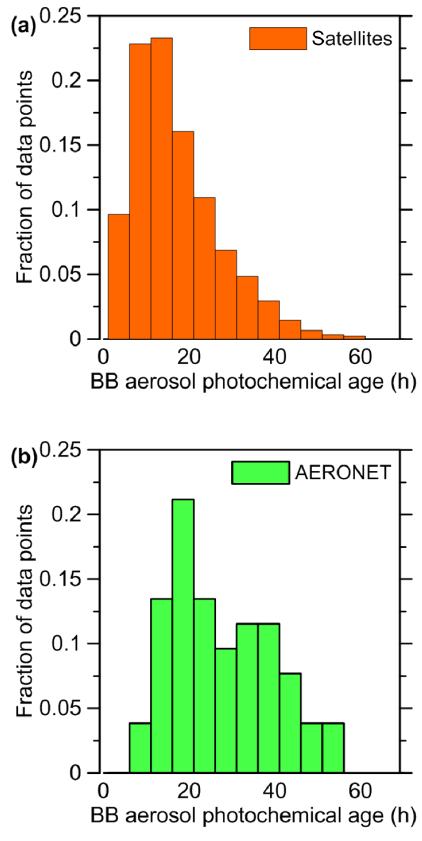
Figure 15. Histograms of the BB aerosol photochemical ages estimated in accordance with Eq. (1) for the (a) satellite and (b) AERONET data selected for this study. Note that very minor fractions of the data points, which correspond to the age exceeding 60 and 56h in the cases of satellite and AERONET data, respec- tively, are not represented in the histograms for the sake of better